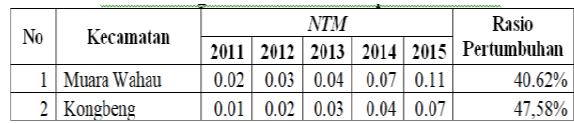
Table 2: Exchange rates of community self-supporting plantations and communities surrounding